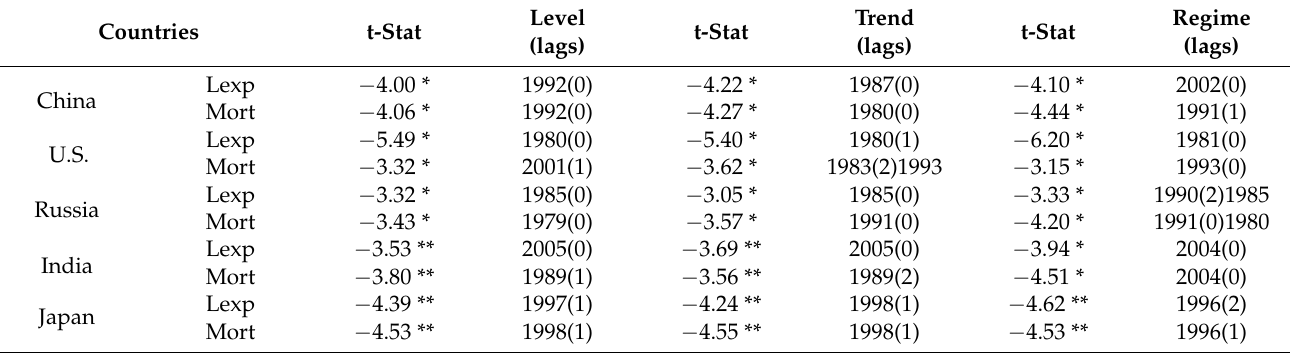
Table 16. Gregory Henson structural break test for all five